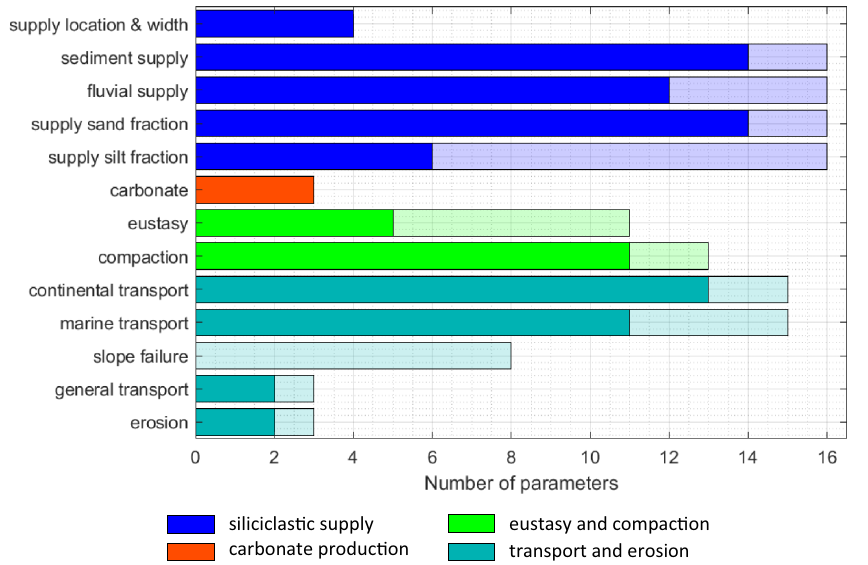
Figure 6. Distribution of the parameters selected in the first step of screening. Semi-transparent bars indicate initial number of parameters, solid bars indicate the number of parameters selected after the first screening step. For more details of the individual parameters found in each group see Supplementary information.